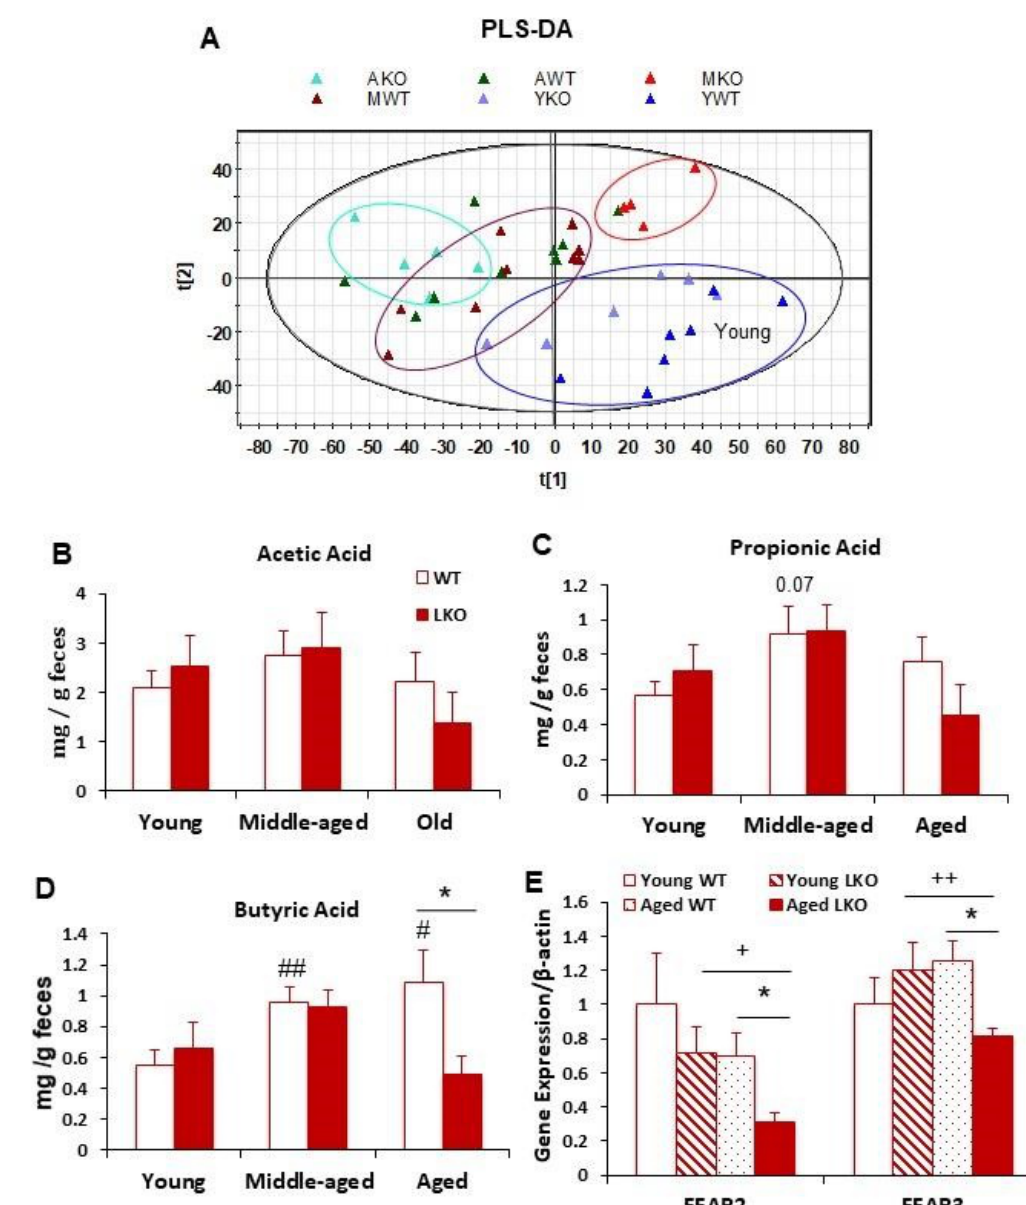
Figure 5. Lcn2 deficiency reduces fecal butyrate levels in old mice. Stool samples from WT and LKO at the ages of 6 months (young), 12 months (middle-aged), and 18 months (old) were homogenized in 50% ACN. ( A ) Data from LC–MS analysis of fecal extracts were processed by latent structures-discriminant analysis (PLS-DA) modeling. Shown is the scores plot of a PSL-DA model on the metabolites in fecal extracts. ( B – D ) Supernatants were collected for HQ reaction to detect SCFAs: acetic acid ( B ), propionic acid ( C ), and butyric acid ( D ). ( E ) mRNA expression levels of free fatty acid receptors FFAR2 and FFAR3 between WT and LKO mice at young and old age. Data are presented as mean ± SEM (n = 5–9). * p < 0.05 versus WT mice. # p < 0.05, ## p < 0.01 versus young WT mice. + p < 0.05, ++ p < 0.01 versus young LKO